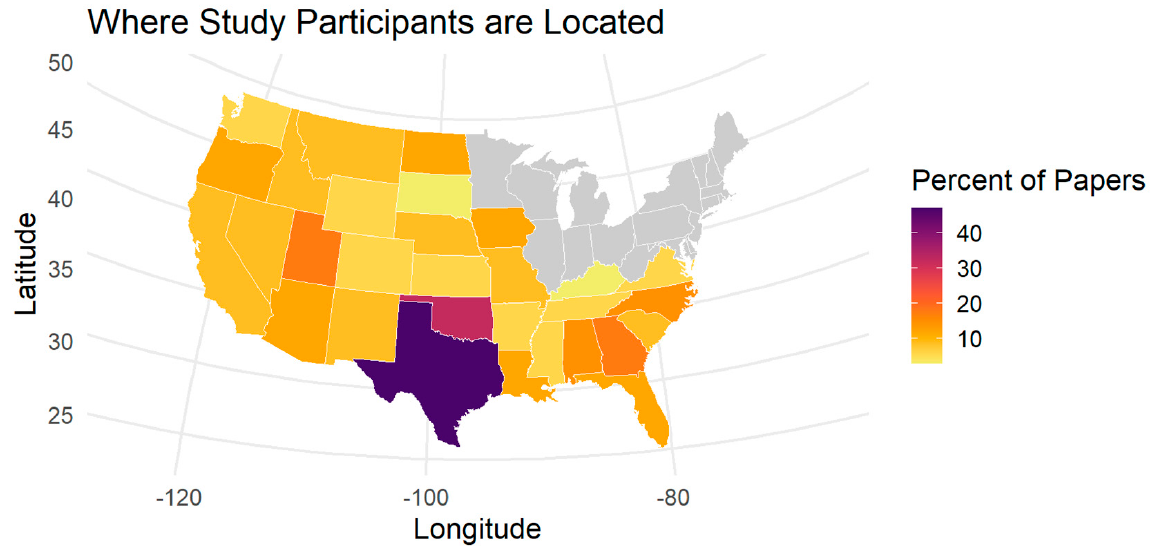
Figure 2. This map shows the location of study participants in 44 articles included in this review. While the Great Plains was the primary focus of this review some of the articles included gathered information from participants in states beyond the Great Plains as